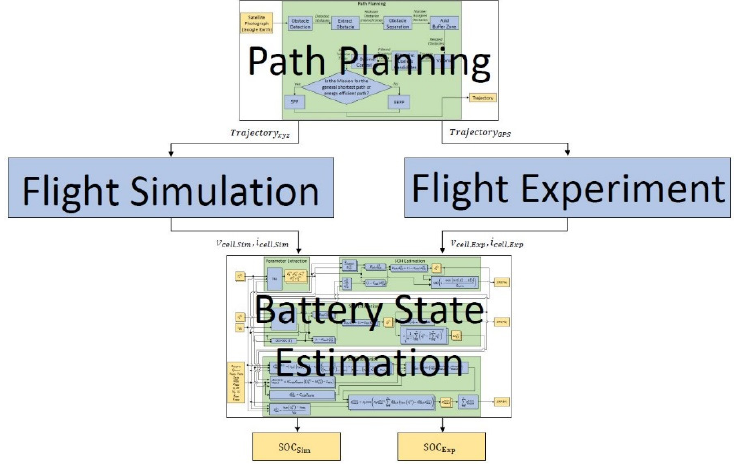
Figure 1. Mission Figure 1. Mission hierarchy.